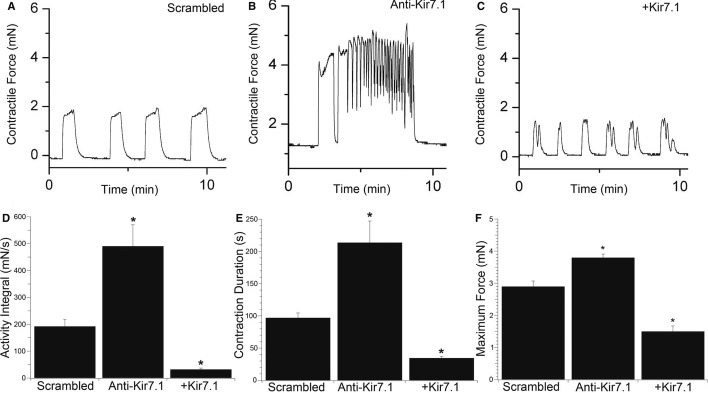
Knockdown of Kir7.1 in vitro increases myometrial activity and promotes tonic contractionsA–C Representative time-force recordings of phasic contractions demonstrating (A) the effect of scrambled miRNA compared to (B) knockdown (Anti-Kir7.1) and (C) overexpression (+Kir7.1) of Kir7.1 on contractility in murine GD15 myometrial strips.D–F Mean data are summarized (n = 8; mean ± SD, per group of experiments) as activity integral (area under the time-force curve) (D), contraction duration (E) and maximum force (F). *P < 0.05, compared to scrambled control by ANOVA with Tukey's post hoc test.